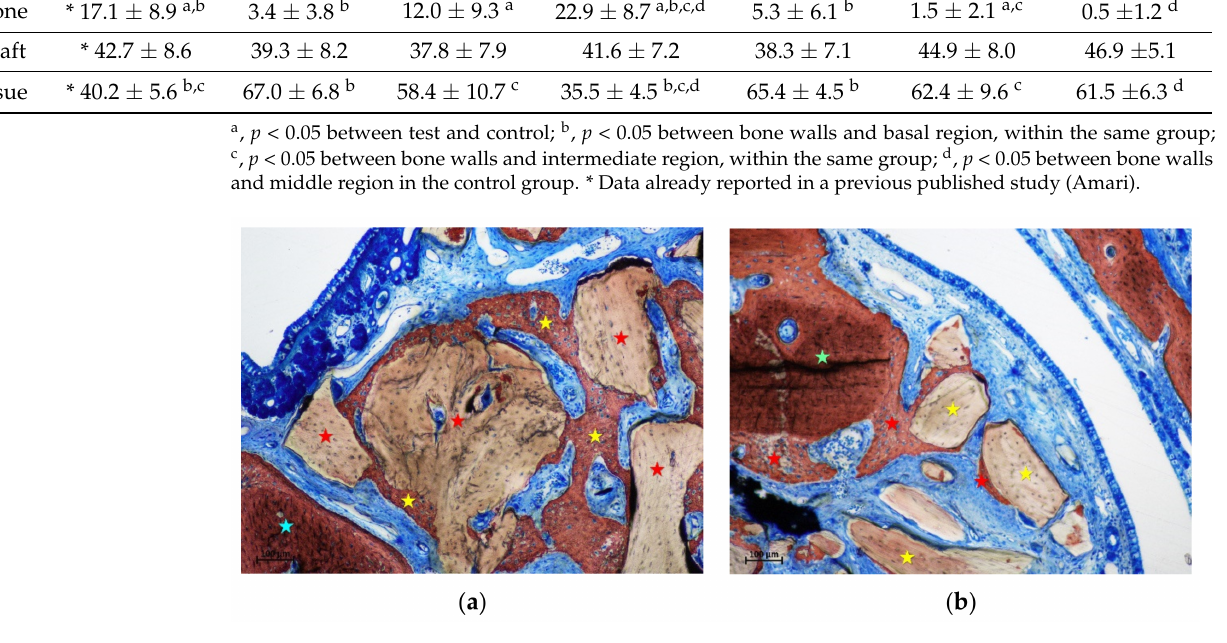
Figure 8. ( a ) photomicrograph of a ground section at the basal region of a control site after 4 weeks of healing. New bone was lining the DBBM surface and in close continuity with the sinus bone walls. ( b ) photomicrograph of a ground section at the intermediate region of a test site after 4 weeks of healing. New bone increased at the test sites, mainly for the contribution of the bone window. Stars indicate example of new bone (yellow), old bone (light blue), inward bone window (light green), and xenogeneic granules (red). Stevenel’s blue and alizarin red